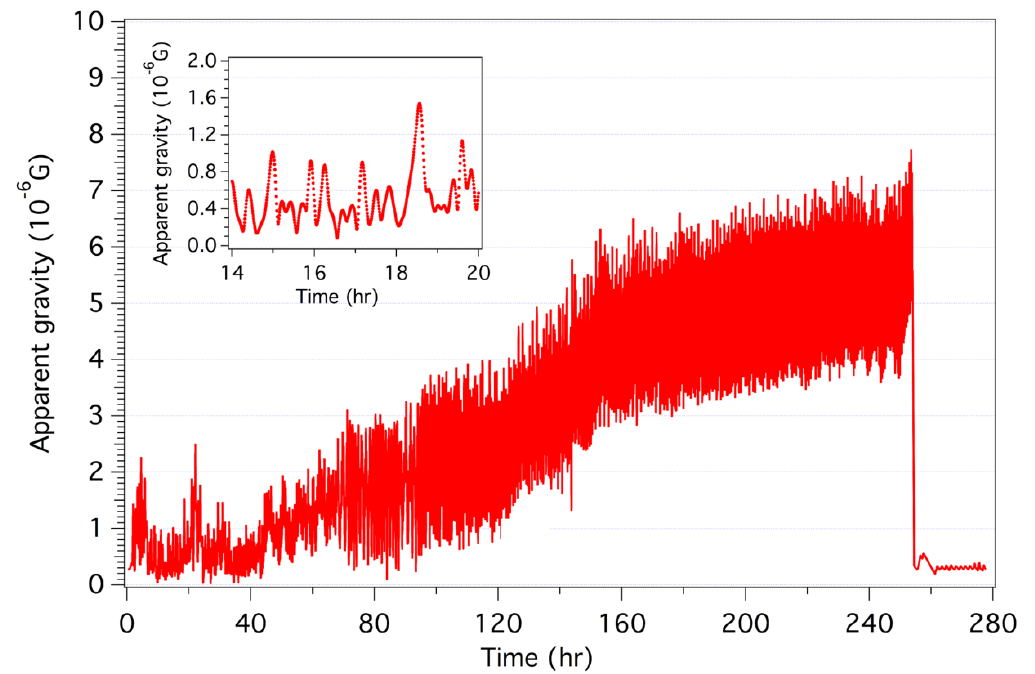
Figure 1. Modulus of the apparent gravity (residual acceleration) as a function of the time (0 is the beginning of the mission). The insert corresponds to the first six hour interval showing the amplitude and duration of the standard oscillation of the gravity level.